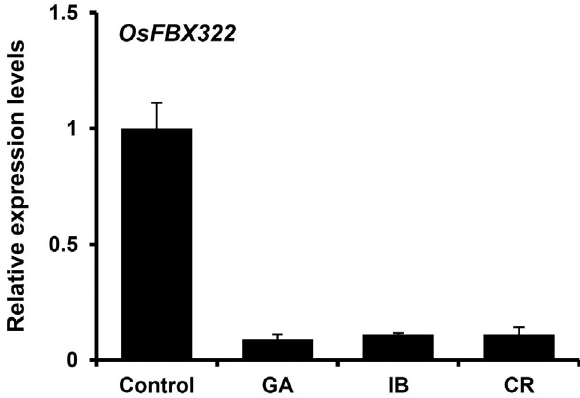
Figure 1 - OsFBX322 expression in 3-week-old rice seedlings after expo- sure to gamma irradiation, ion beams, or cosmic rays. Quantitative RT-PCR analysis of OsFBX322 expression after irradiation. The ACT1 transcript was used for normalization of mRNA content. Transcript levels are displayed relative to ACT1 mRNA in non-treated plants (control). Control,non-irradiated;GA,200Gygamma-irradiation;IB,40Gycarbon ions; CR, exposure on an unmanned spacecraft for 15